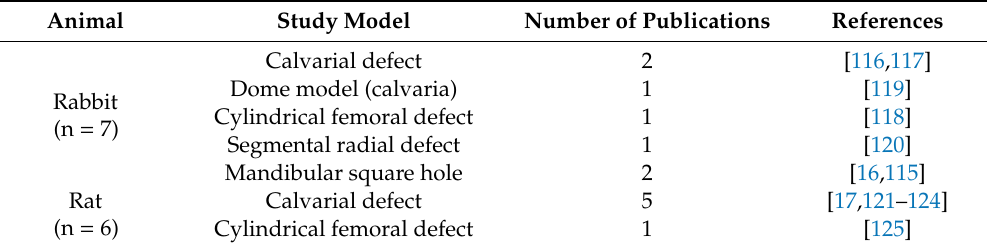
Table 3. Distribution of defect types among the included